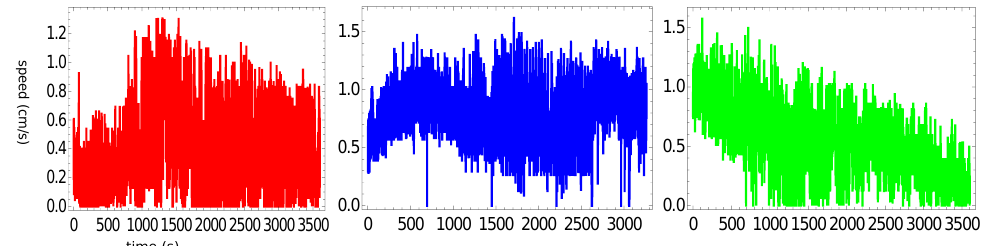
Figure 7. The radial distribution function of the positions of pill centers calculated from the distances illustrated in Figure 6. The same color is used to draw the radial distribution function and the trajectory.